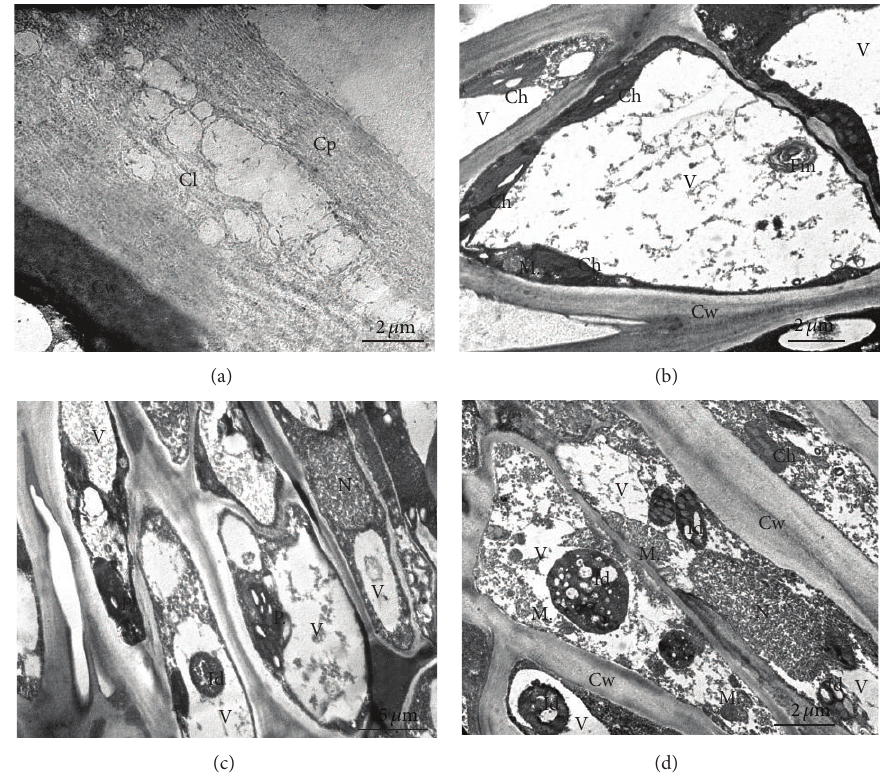
Figure 8: TEM: ultrastructure of the “Conference” ((a)–(c)) and “Clapp’s Favourite” (d) fruit peel at the fruit set stages; (a) fragment of the fruit cuticle; (b) epidermis cell; ((c), (d)) hypodermis; Cp: cuticle proper, Cl: cuticular layer, N: nucleus, Ch: chloroplasts with starch grains, M: mitochondrion, V: vacuoles, P: plastids with starch grains, Mf: myelin figure, Id: intravacuolar deposits, and Cw: cell